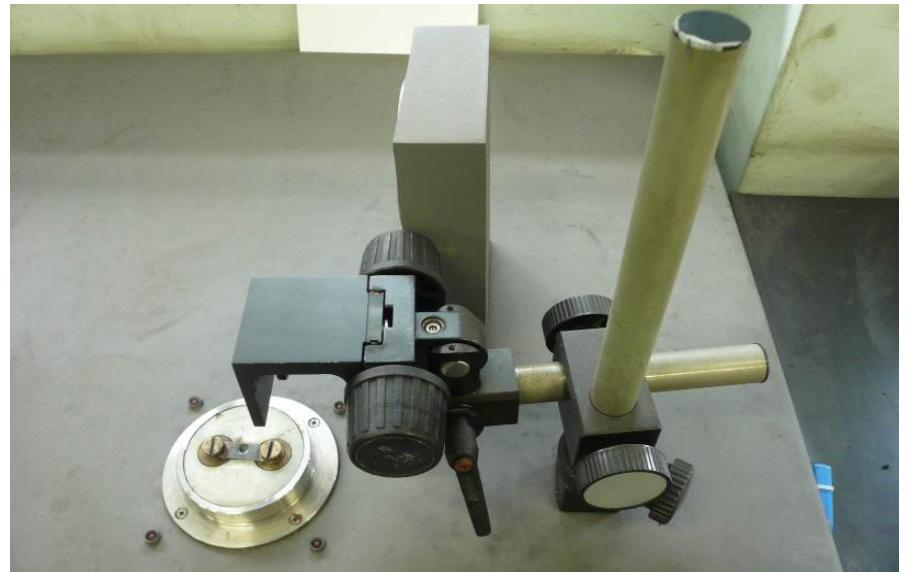
Figure 2. The photo of ignition